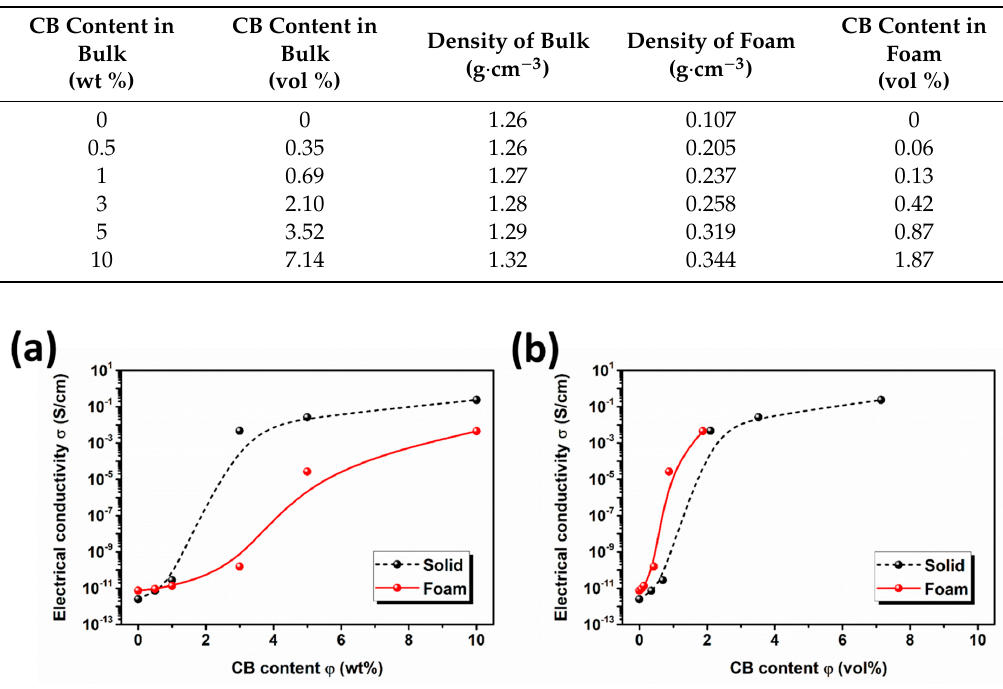
Table2. DensityvaluesofPBS / CBnanocompositesandnanocompositefoamswithdi ff erentCBcontents.